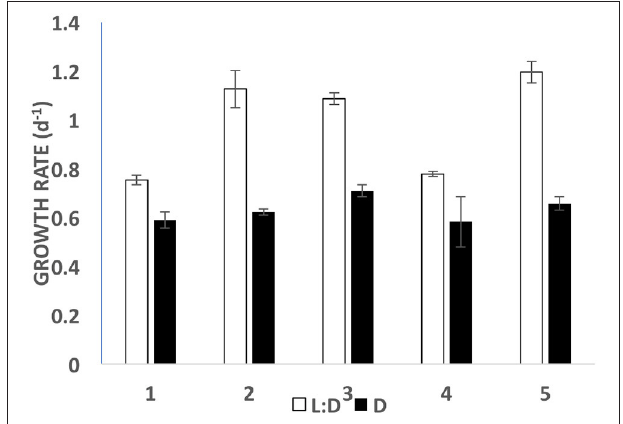
FIGURE 8 | Growth rates in light (open bars; 12:12 photoperiod at c. 70 µ mol m − 2 s − 1 ) vs. dark (filled bars) for five short term (5–8 day) experiments. Error bars are standard deviations ( n = 3).